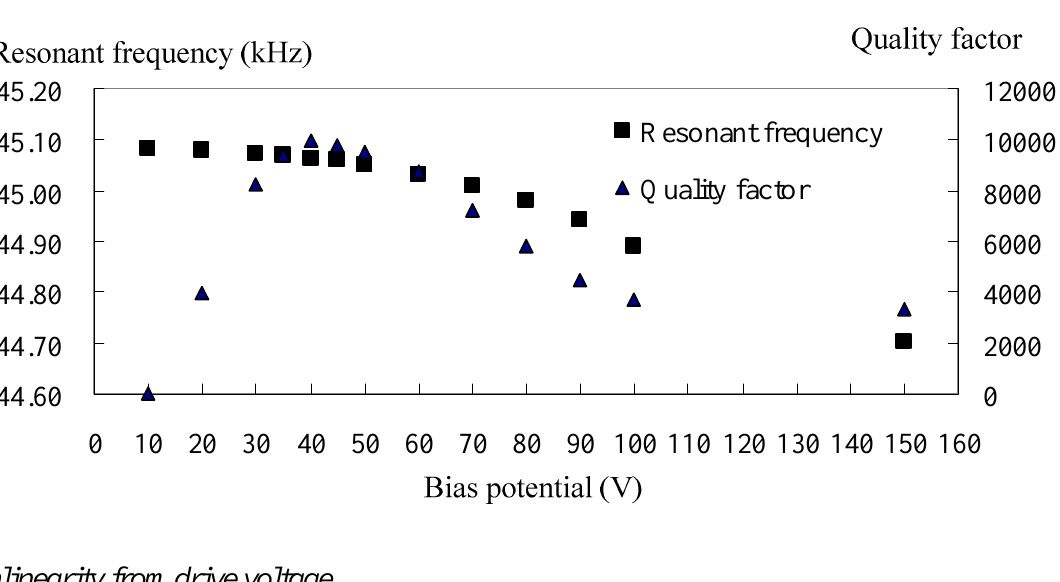
Figure 9. Nominal quality factor and resonant frequency as a function of bias potential for Device D 1 f